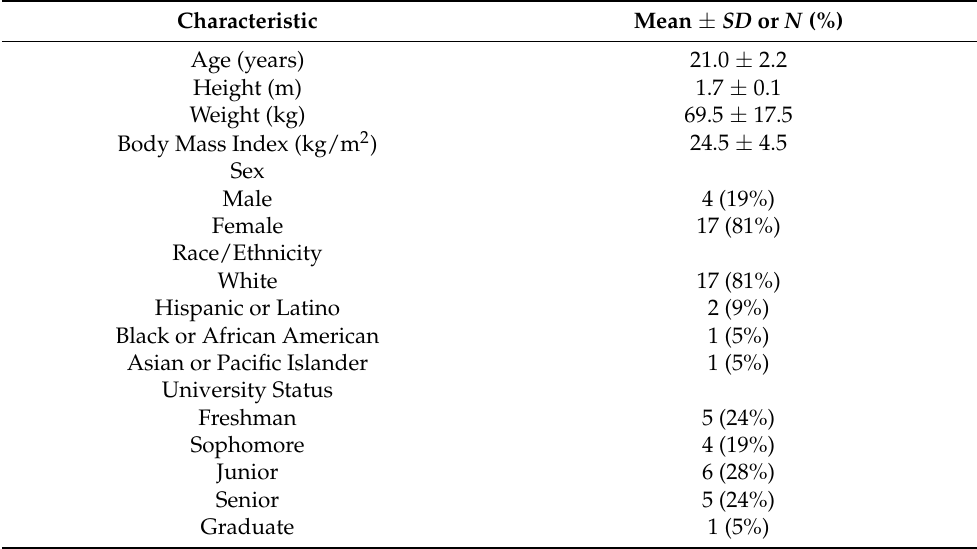
Table 1. Demographic characteristics of the analyzed sample ( N = 21).